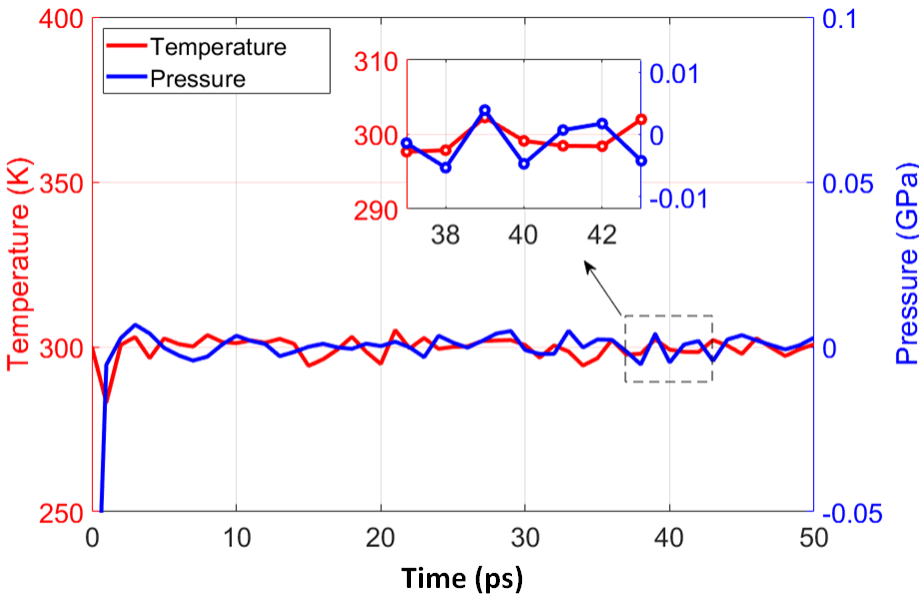
Figure 3. A typical process of system equilibration. The temperature and pressure fluctuate to achieve equilibrium at approximately 10 ps. The target temperature is T = 300 K, and the target pressure is P = 0.0001 GPa. The timestep is 0.001